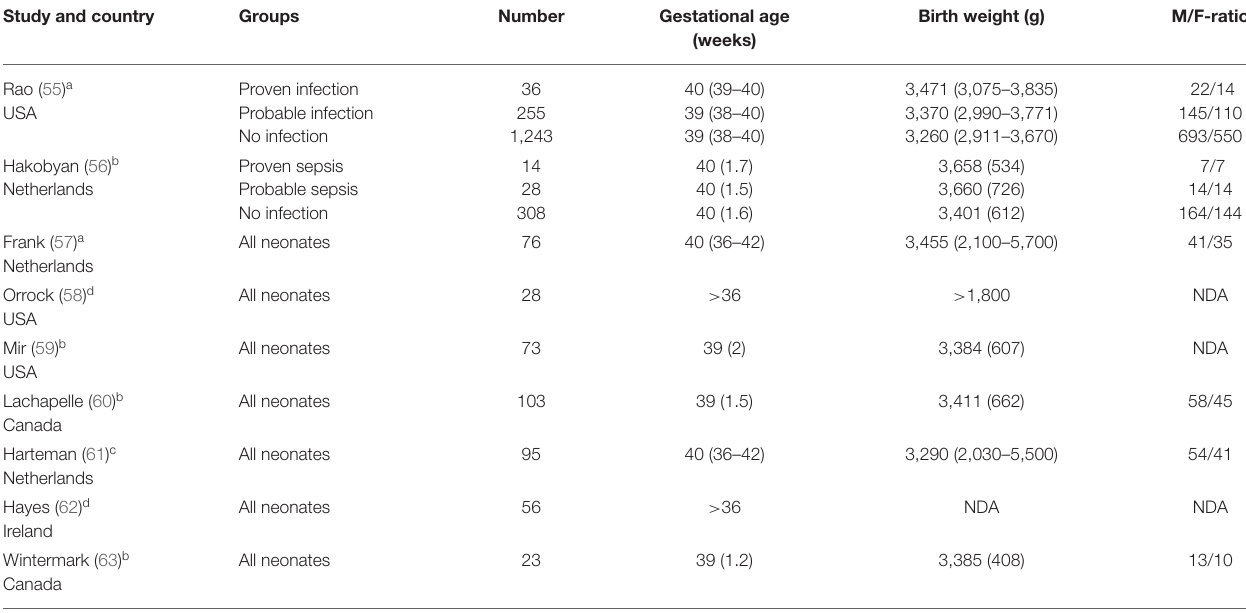
TABLE 1 | Number, gestational age, birth weight, and male to female (M/F) ratio of the newborns in the studies investigating the association between newborn encephalopathy, perinatal infection, and neurological outcome. Study and